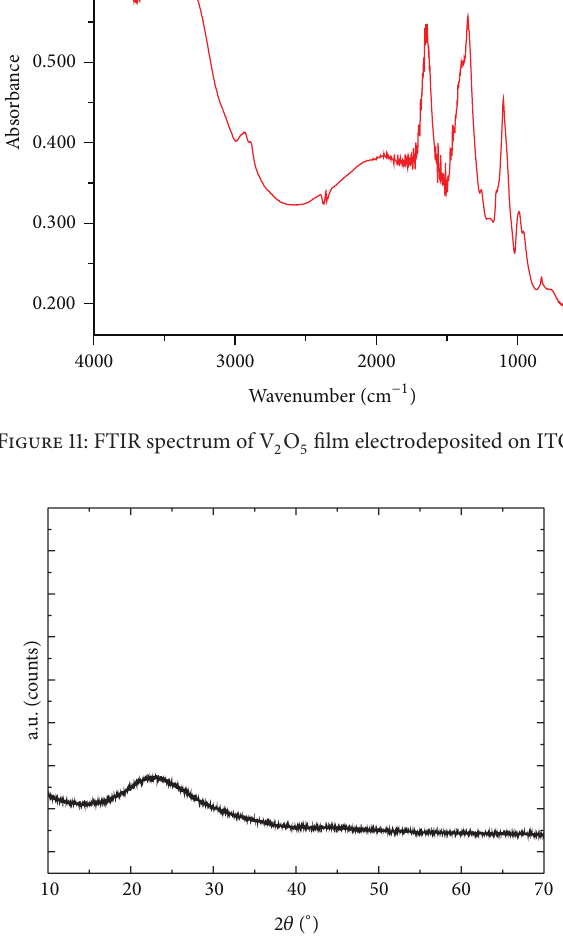
Figure 12: Typical X Ray diffraction pattern of the sputtered WO 3 film.